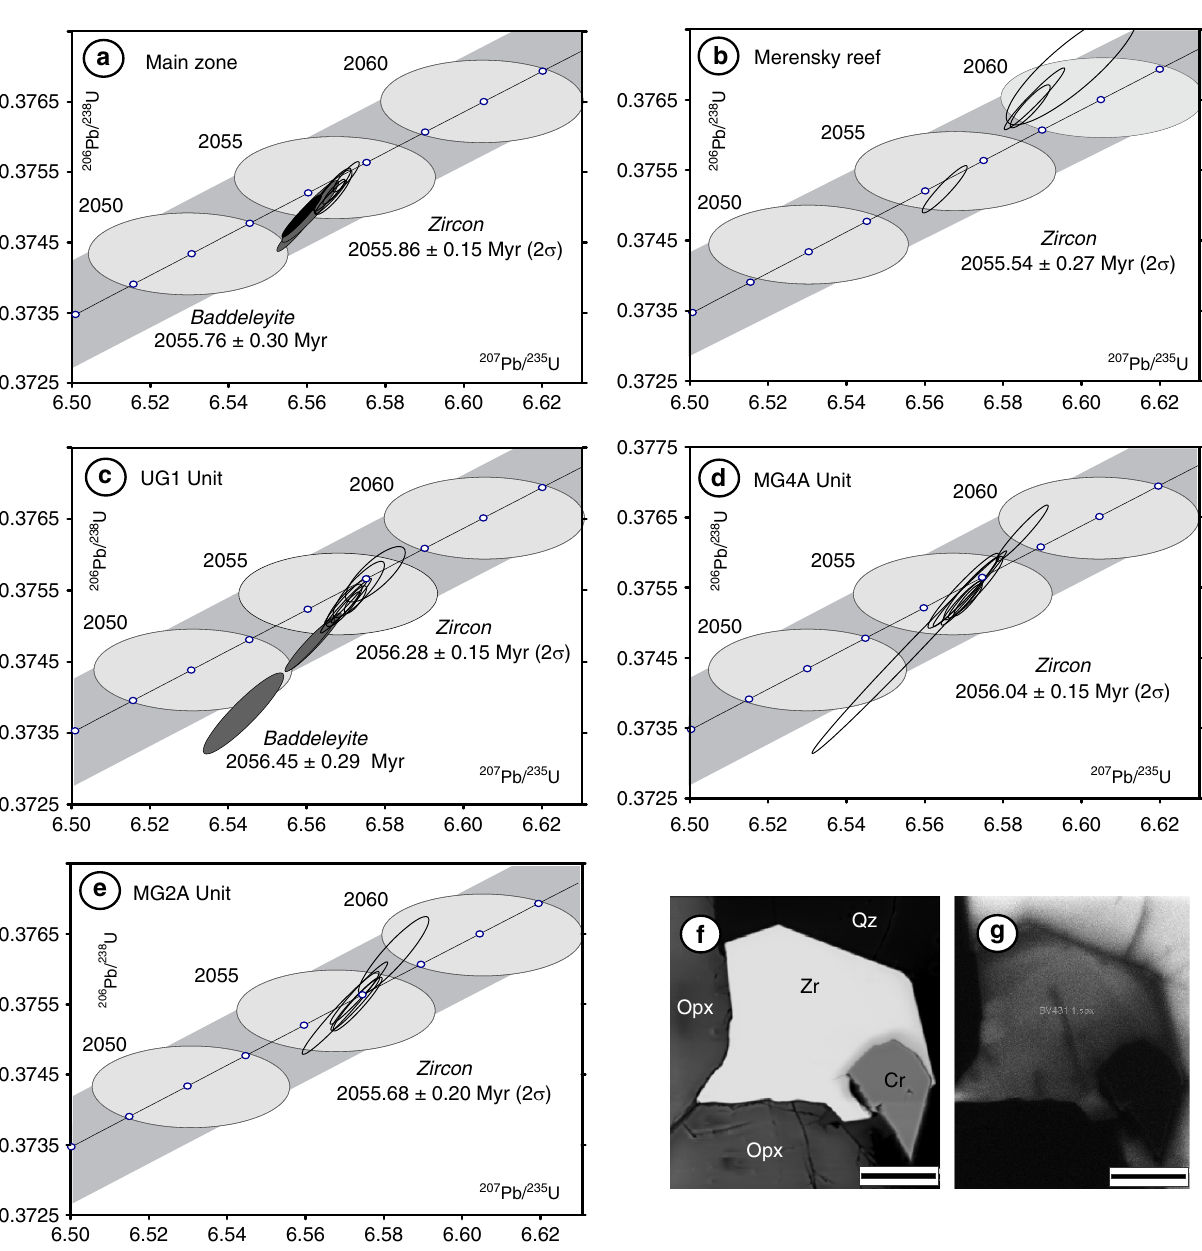
Figure 6 | Results for five dated samples from the Main and Upper Critical zones of the Rustenburg Layered Suite. a – e show concordia diagrams for data listed in Table 1 and described in the text. Hollow ellipses represent U–Pb results for zircon; grey ellipses represent U–Pb results for baddeleyite; black ellipse in a represents the one slightly younger fraction in the Main Zone sample; all ellipses represent 2 s errors. The broad grey bands indicate the uncertainty in the concordia related to uncertainty in the decay constants for U isotopes; errors on individual age points along the concordia are indicated by large grey ellipses superimposed on the concordia curve. All zircon and most baddeleyite data are concordant within uncertainties in the decay constants. Quoted ages are weighted mean 207 Pb/ 206 Pb ages. It is noteworthy that the Main Zone appears to be older than the Merensky Reef, and both the MG4A and MG2A units are younger than the UG1 unit. f shows a backscattered electron image of typical igneous zircon (Zr) overgrowing pyroxene (Opx) and chromite (Cr), in turn enclosed in quartz (Qz) in feldspathic pyroxenite (Sample BV431, UG1 Unit). g shows a cathodoluminescence image of the same field of view as f . Scale bar, 40 m m ( f , g